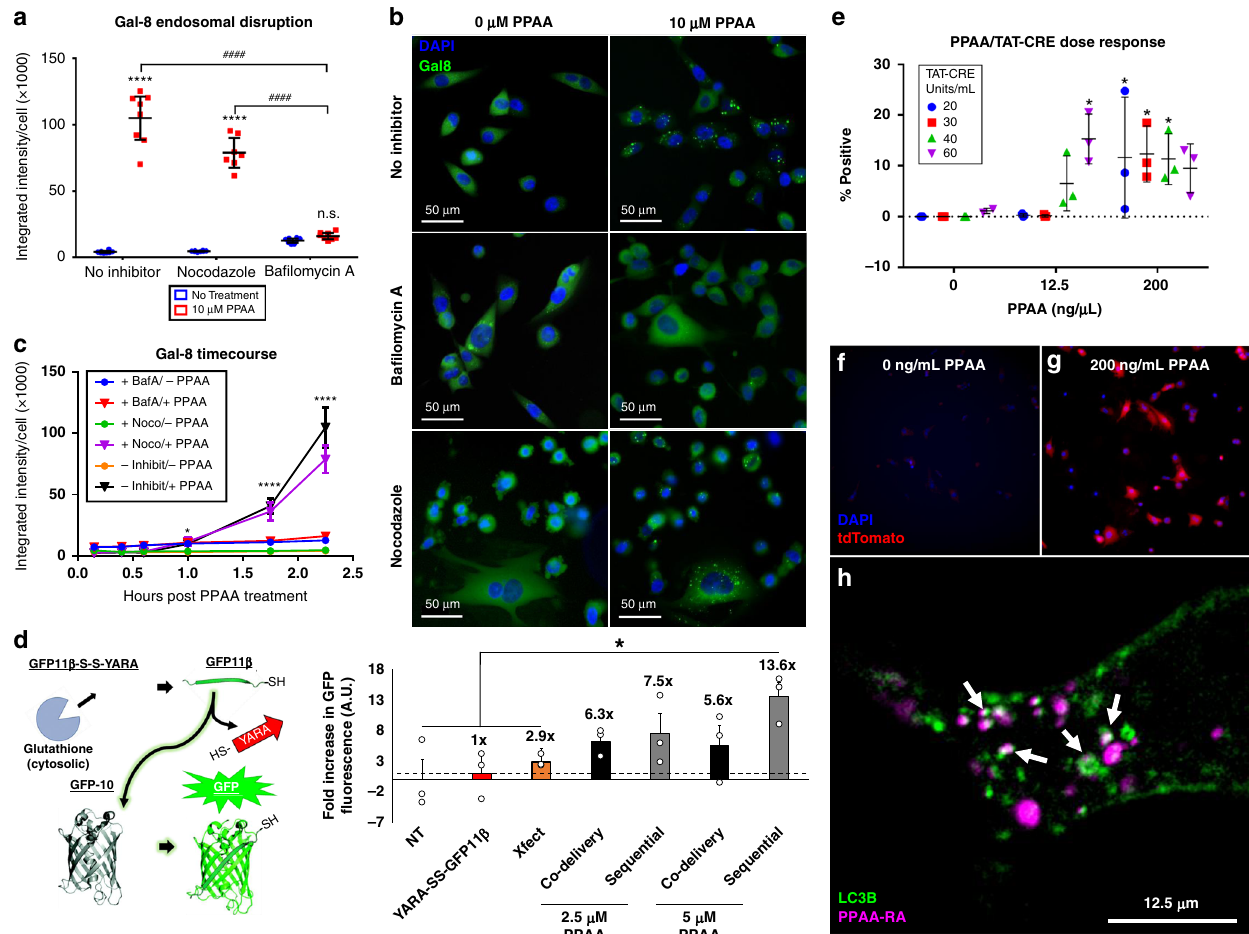
Fig. 4 PPAA facilitates endosomal escape and is subsequently traf fi cked to autophagosomes. a Galectin-8 recruitment measured as the average Galectin-8 intensity per cell 2 h post-treatment with 0 or 10 µ M PPAA in the presence or absence of the endosomal acidi fi cation inhibitor ba fi lomycin A and its control nocodazole. Data are presented as means ± 95% CI; two-way ANOVA followed by Tukey ’ s post hoc test. b Representative microscopy images of the treatment groups presented in A. Images are 712.8 × 712.8 µ m. c Tracking in real-time indicates that PPAA causes signi fi cant (* p < 0.05) endosomal disruption compared with no treatment after 1 h which increases over the timeframe measured. Data are presented as means ± standard deviation. For a , c , * p < 0.05, **** p < 0.0001 vs. no inhibitor, #### p < 0.0001. d Comparison of delivery reagent-mediated intracellular peptide bioavailability through a quantitative split-GFP fl uorescence transduction assay (numbers above bars denote the fold increase in GFP fl uorescence compared with delivery of the peptide corresponding to the eleventh β -strand of the GFP protein alone); * p < 0.05; one-way ANOVA followed by Tukey ’ s post hoc test. Data are presented as means ± SEM. e PPAA dose-dependent intracellular delivery of TAT-CRE to Ai9 fi broblasts expressing a loxP fl anked stop cassette upstream of a tdTomato transgene. Data are expressed as the percentage of treated cells positive for tdTomato expression as a measure of the intracellular bioavailability of the TAT-CRE cargo (12.5 ng/ µ L = 0.56 µ M, 200 ng/ µ L = 9.1 µ M PPAA). Two-way ANOVA testing of the data revealed a signi fi cant effect of PPAA dose on TAT-CRE mediated gene recombination ( p < 0.0001). Tukey ’ s post hoc multiple comparisons testing for simple effects within each TAT- CRE dose revealed signi fi cant differences in gene recombination with increasing doses of PPAA; * p < 0.05. Data are presented as means ± standard deviation. Representative images of Ai9 fi broblasts pretreated with f 0 and g 200 ng/mL PPAA prior to treatment with 40 units/mL TAT-CRE. Images are 712.8 × 712.8 µ m. h Representative still frame (from Supplementary Movie 4) demonstrating that LC3B (green) co-localizes (white arrows) with